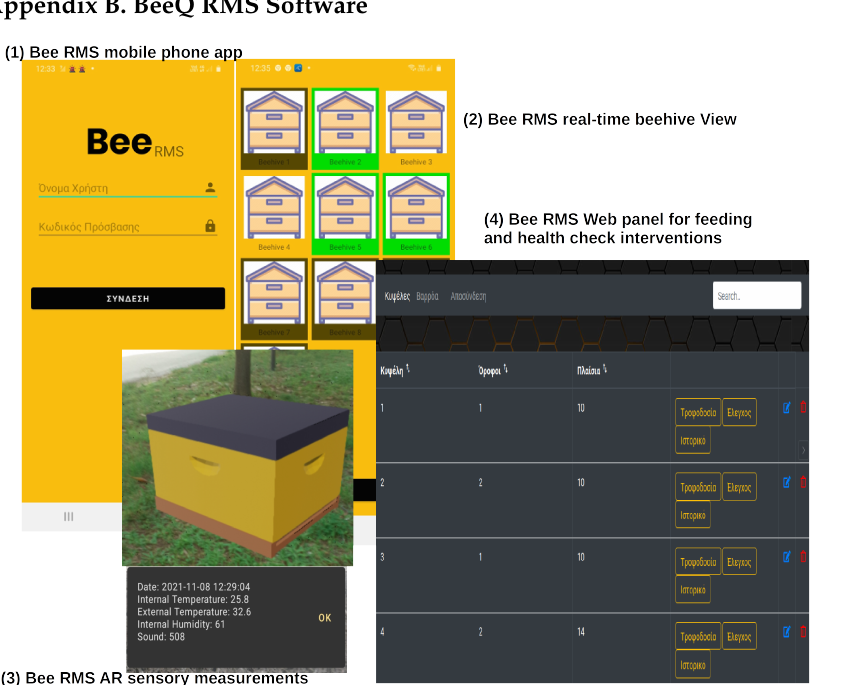
Figure A4. (1) BeeQ RMS system, (2) Android mobile phone application and sensory grid view of active beehives, (3) BeeQ RMS mobile phone sensory real-time measurements and AR beehive pose, and (4) BeeQ RMS web panel for feeding and health status check practices.